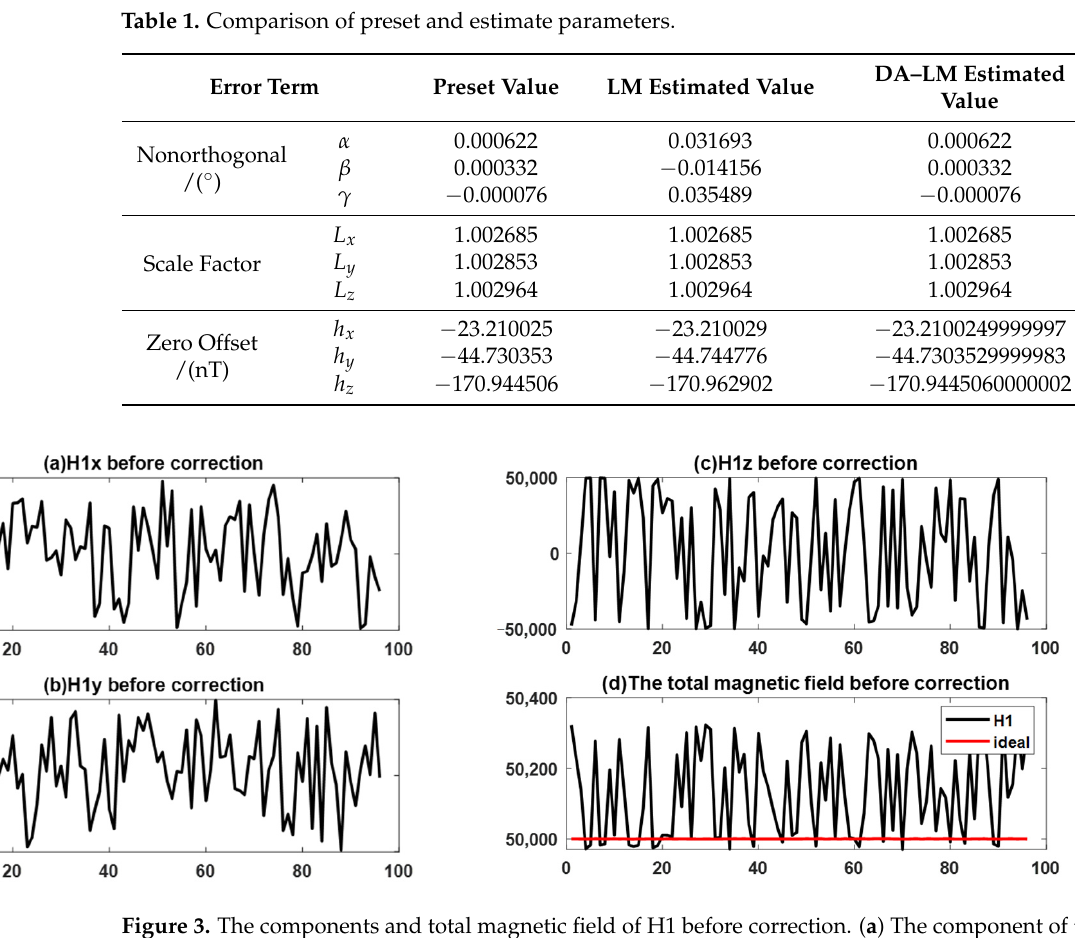
Figure 4. The errors of components and total magnetic field before and after correction. ( a ) The errors of the x–axis; ( b ) The errors of the y–axis; ( c ) The errors of the z–axis; ( d ) The errors of measured total magnetic field before and after correction.